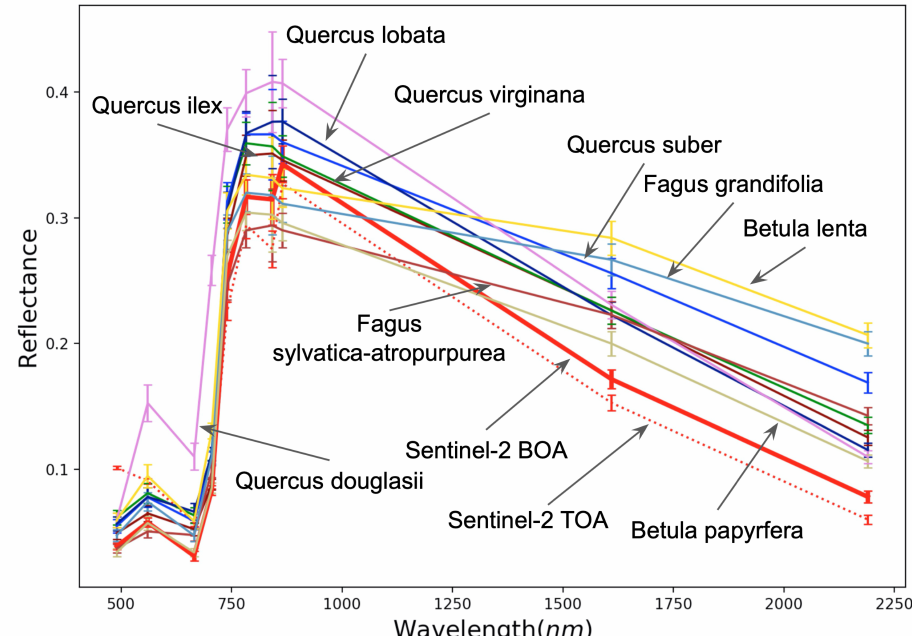
Figure 9. Spectral reflectance profiles for the simulation using the leaf spectral reflectance data as